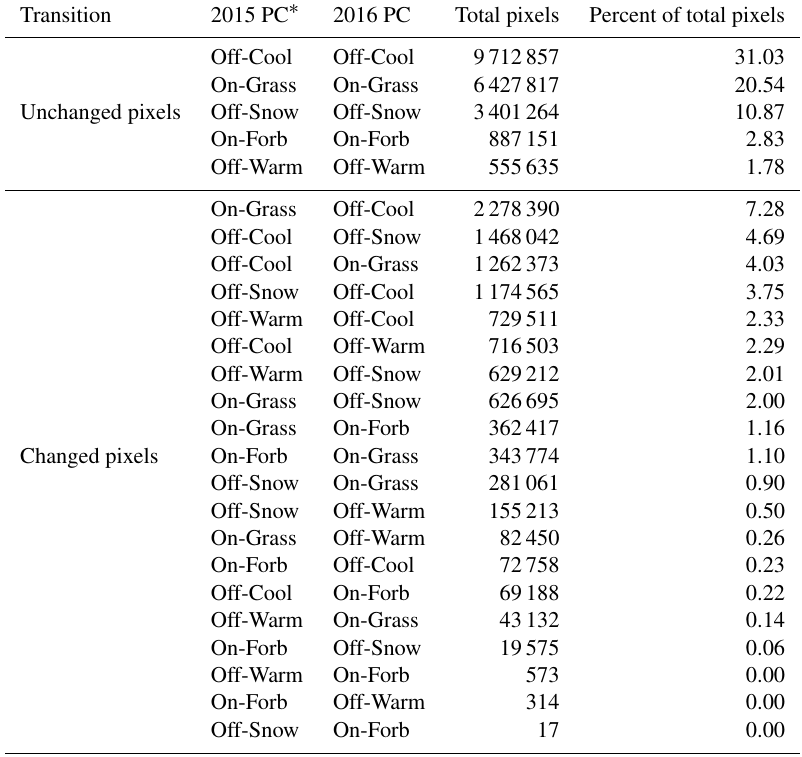
Table 4. Percent of pixels within each plant community that remain unchanged and that changed class between 2015 and 2016 models.